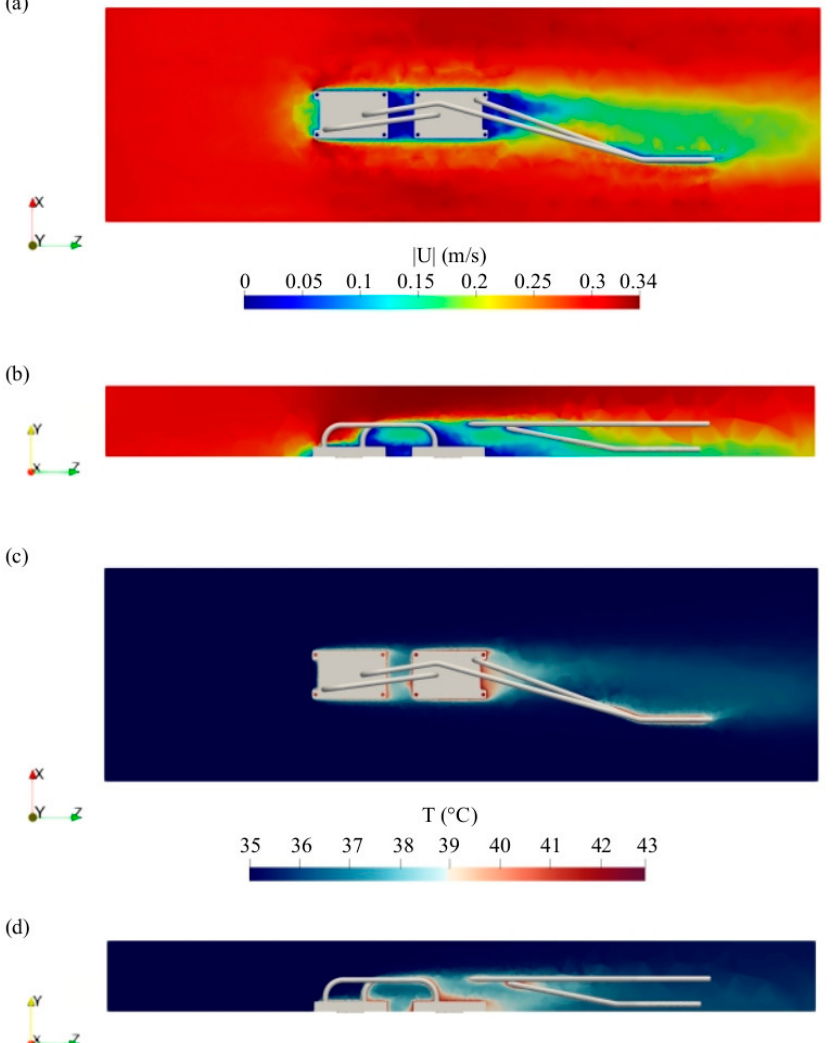
Figure 13. Velocity distributions from ( a ) top and ( b ) side views; temperature distributions from ( c ) top and ( d ) side views.